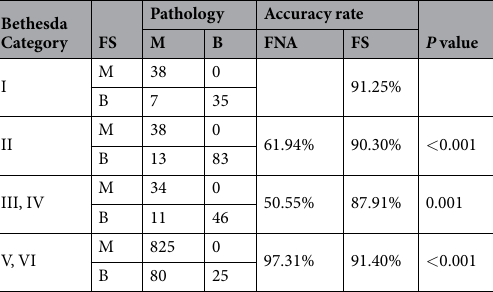
Table 3. Diagnostic accuracy of FNA and intraoperative FS. Note: M, malignant; B, benign; FNA, fine needle aspiration; FS, frozen